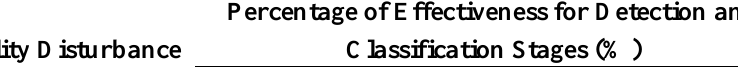
Table 4. Proposed methodology effectiveness for detection and classification in noiseless (NL) and noisy (N) conditions.